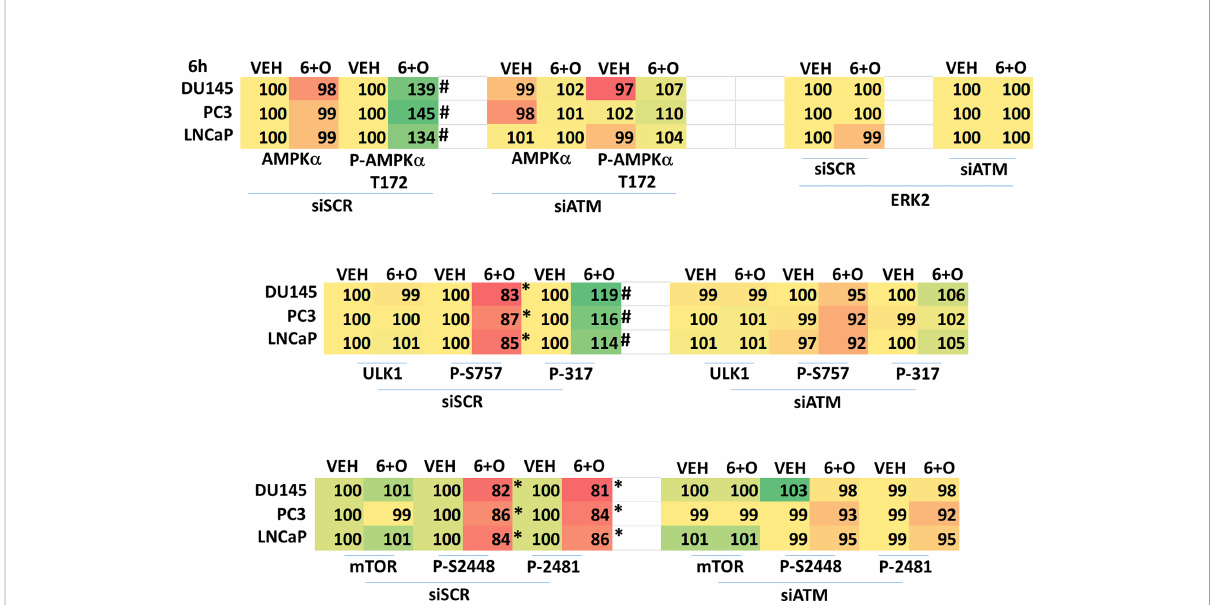
FIGURE 2 Regulation of AMPK, ULK1 and mTOR by [GZ17-6.02 + olaparib] requires ATM. Cells were transfected with a scrambled siRNA or with an siRNA to knock down expression of ATM. After 24h, cells were treated with vehicle control or [GZ17-6.02 (2 m M) and olaparib (50 nM)] in combination for 6h. Cells were fi xed in situ, permeabilized, stained with the indicated validated primary antibodies and imaged with secondary antibodies carrying red- and green- fl uorescent tags. The staining intensity of at least 100 cells per well/condition is determined in three separate studies. The graphical data presented are the normalized amount of fl uorescence set at 100% comparing intensity values for vehicle control (n = 3 +/-SD). # p < 0.05 greater than vehicle control; * p < 0.05 less than vehicle